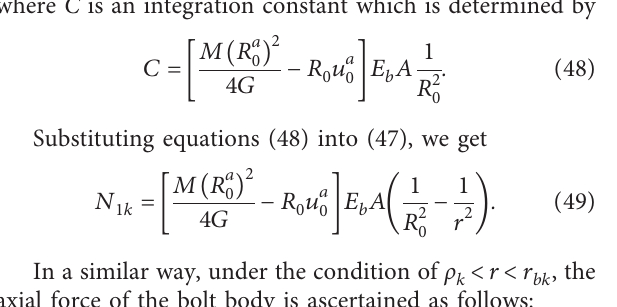
Figure 12: The relative outer diameter range of the ( k +1)-th fractured zone and plastic zone in the surrounding